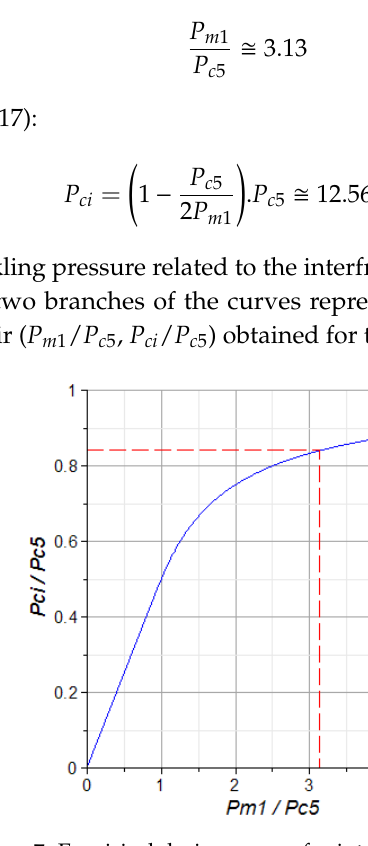
Figure 7. Empirical design curves for interframe collapse.